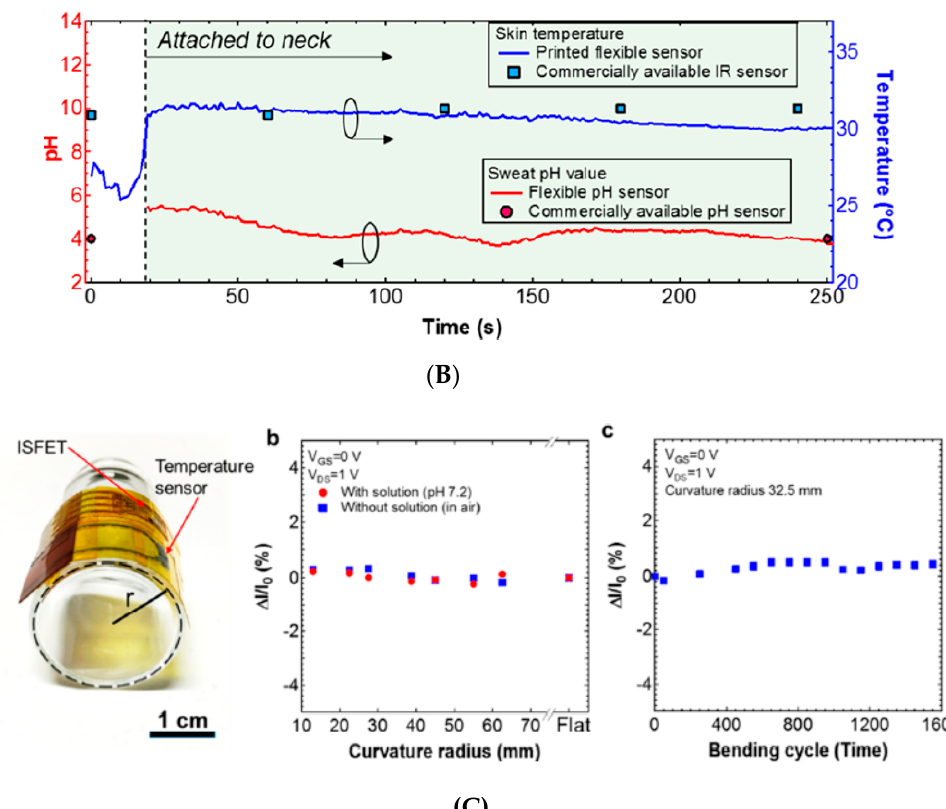
Figure 20. ( A ) a—Scheme of the flexible strip integrating pH and temperature sensors; b—Side view of the encapsulated sensors; c—Picture of the strip held between two fingers. d, e—Details of the two sensors. ( B ) Real-time pH and skin temperature acquired from the neck of a patient, by the device (continuous lines) and measured by commercial pH and infrared sensors (squares and circles). ( C )